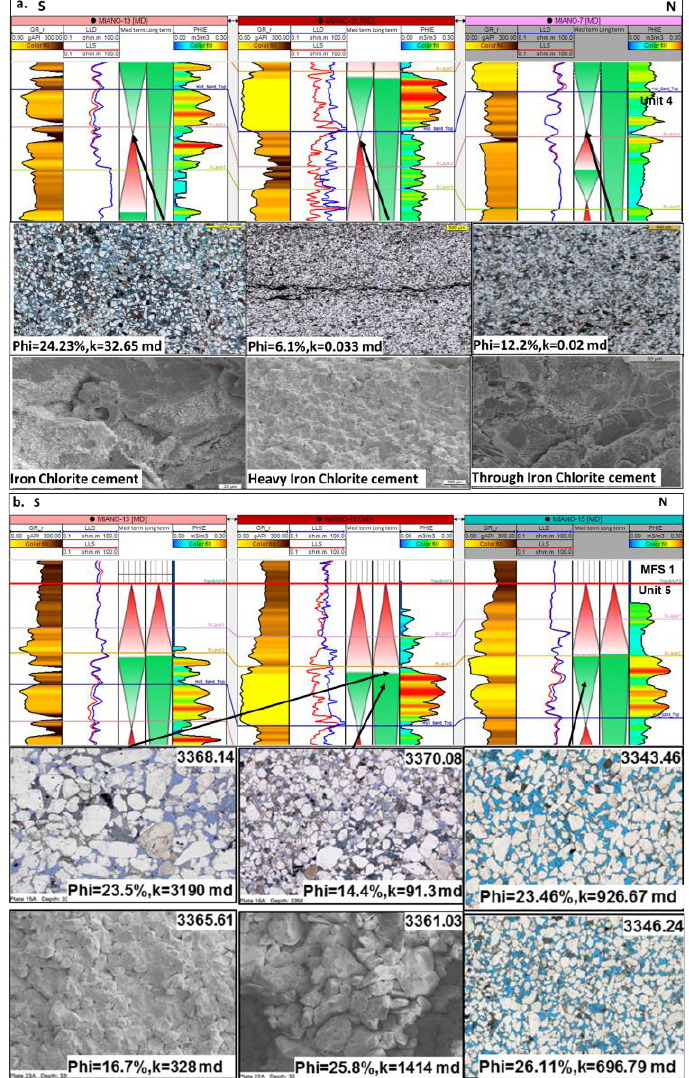
Figure 9. Reservoir quality variation trends in Unit 4 ( a ) and Unit 5 ( b ). In Unit 4, where the